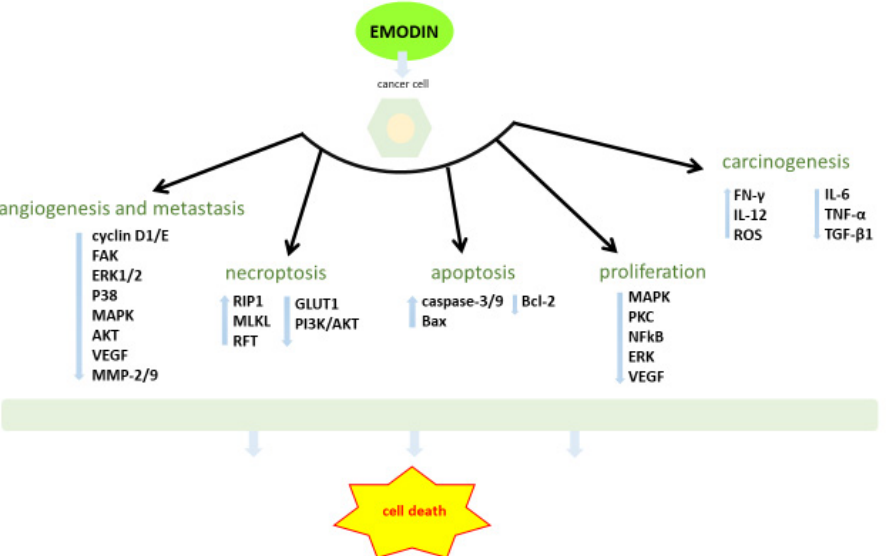
Figure 3. The main anticancer molecular mechanism of emodin. FAK: focal adhesion kinase; ERK1/2: extracellular signal-regulated protein kinase 1/2; MAPK: mitogen-activated protein kinase; AKT: oncogenic protein kinase B; VEGF: vascular endothelial growth factor; MMP: matrix metalloproteinase; RIP1: receptor-interacting protein 1; MLKL: mixed lineage kinase domain like pseudokinase; RFT: fibroblast growth factor 2 (FGF-2) transcription; Bax: bcl-2-like protein 4; Bcl-2: B-cell lymphoma 2; PKC: protein kinase C; NF- κ B: nuclear factor kappa-light-chain-enhancer of activated B cells.